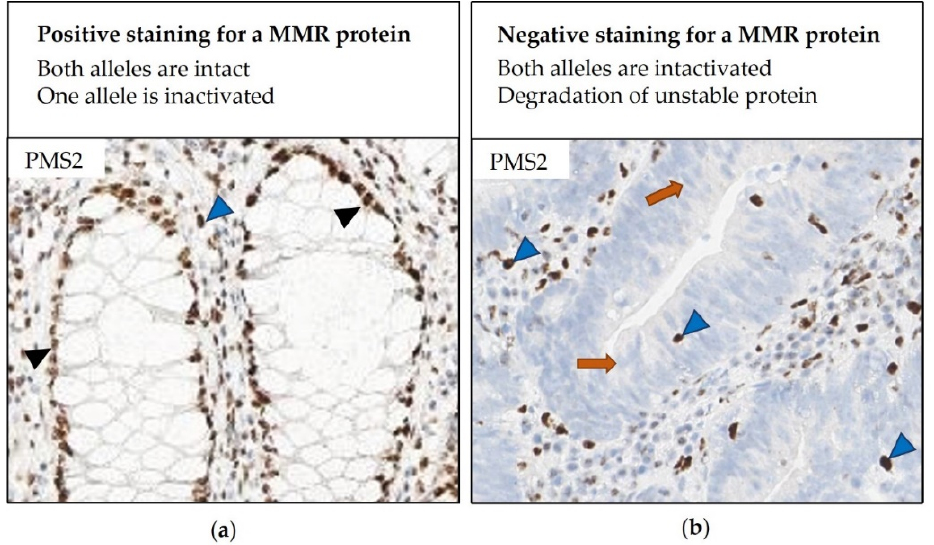
Figure 4. Immunohistochemistry for the detection of MMR proficiency or MMR deficiency. Exemplarily depicted is immunostaining for PMS2 on colon tissue ( a ) with an adenocarcinoma ( b ). Normal colon tissue ( a ) with positive nuclear staining in crypt enterocytes (black arrowheads) and infiltrating lymphocytes (blue arrowhead) as well as some fibrocytes/fibroblasts (not labeled); Colon adenocarcinoma ( b ) with immunonegative tumor cells (orange arrows) and positive lymphocytes (blue arrowheads) as well as some positive stromal cells (not labeled). Tissue kindly provided by Pathology Nordhessen, Kassel, Germany .